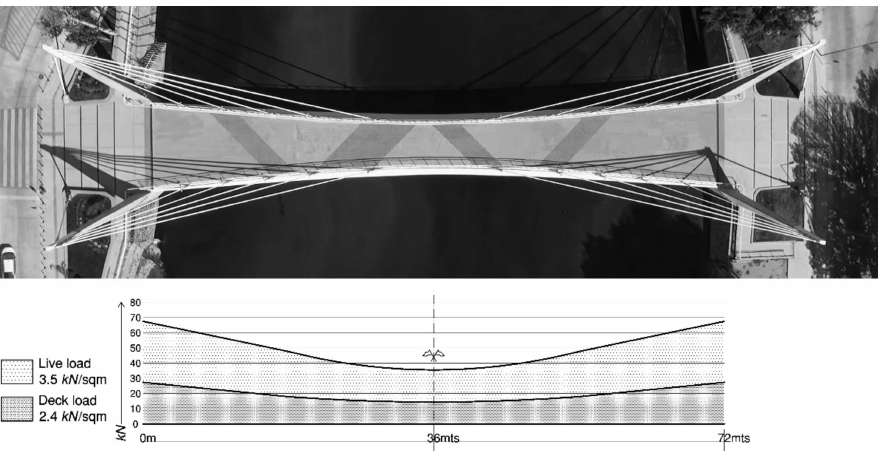
Figure 11. Top : the deck geometry in the plan widens from 6mts at the center to 11.4 m at the entry points. Bottom : the load diagram places most of the mass closer to the abutments and onto the more efficient stays.